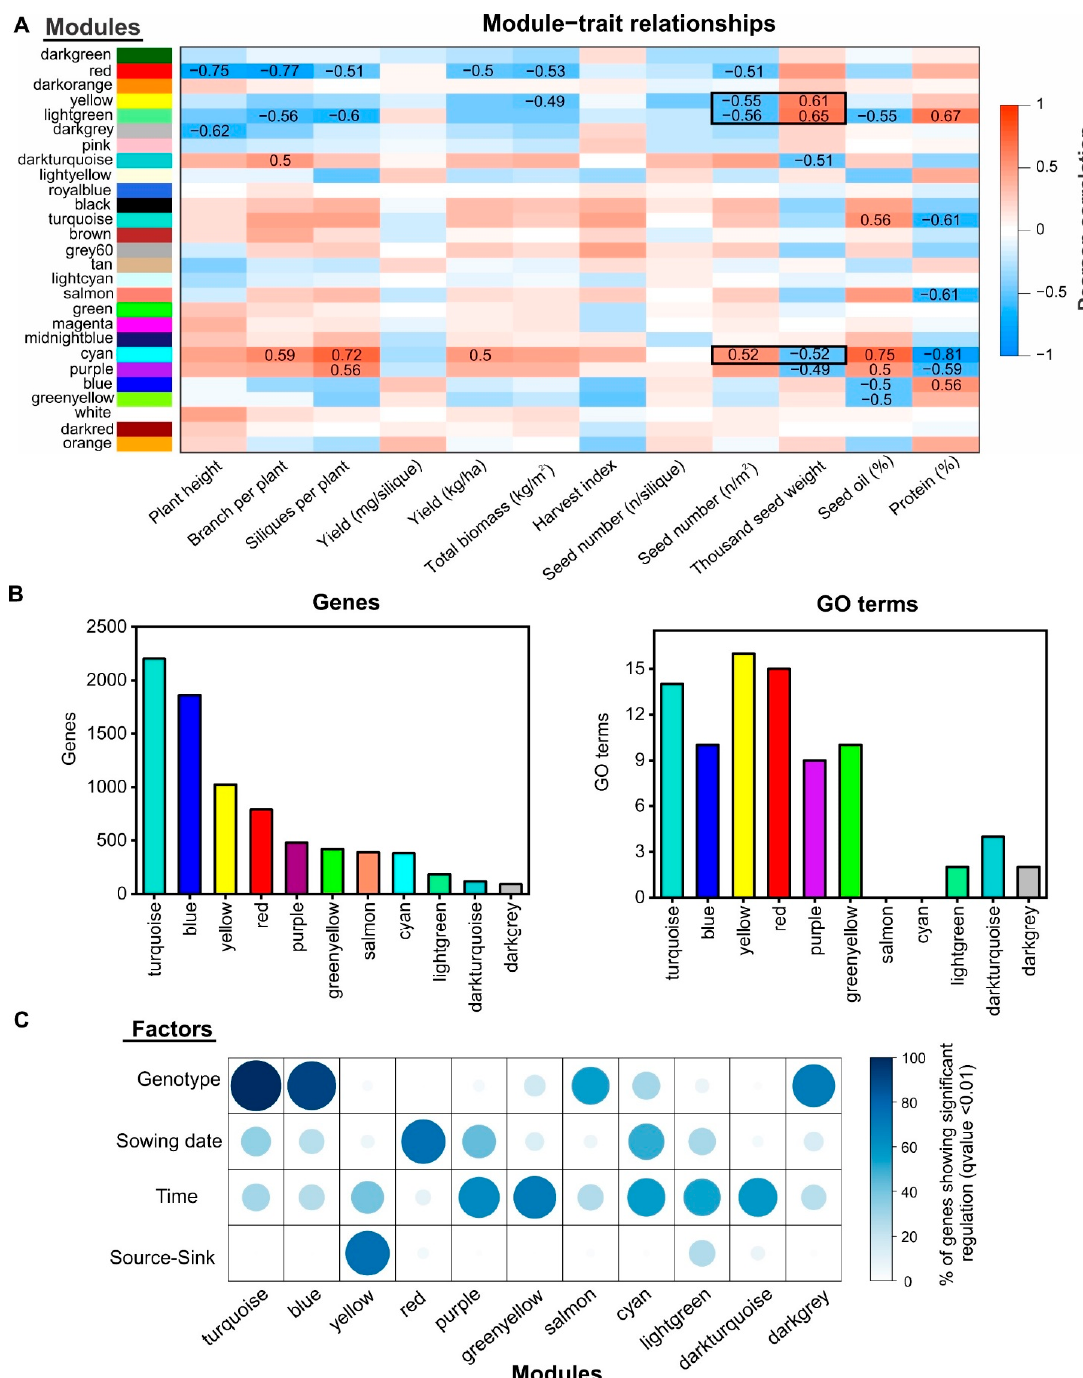
the mean (SEM) of three replicates. The Arabidopsis ortholog of each rapeseed gene is indicated in brackets. ( C ) Ex- pression profiles of three representative genes for which the orthologs in Arabidopsis are involved in seed weight reg- ulation. The dots represent the average log 2 fold of change between shading and control samples obtained from nor- malized RNA-seq data, whereas bars indicate the standard error of the mean (SEM) of three replicates. The Arabidop- sis ortholog of each rapeseed gene is indicated in brackets.